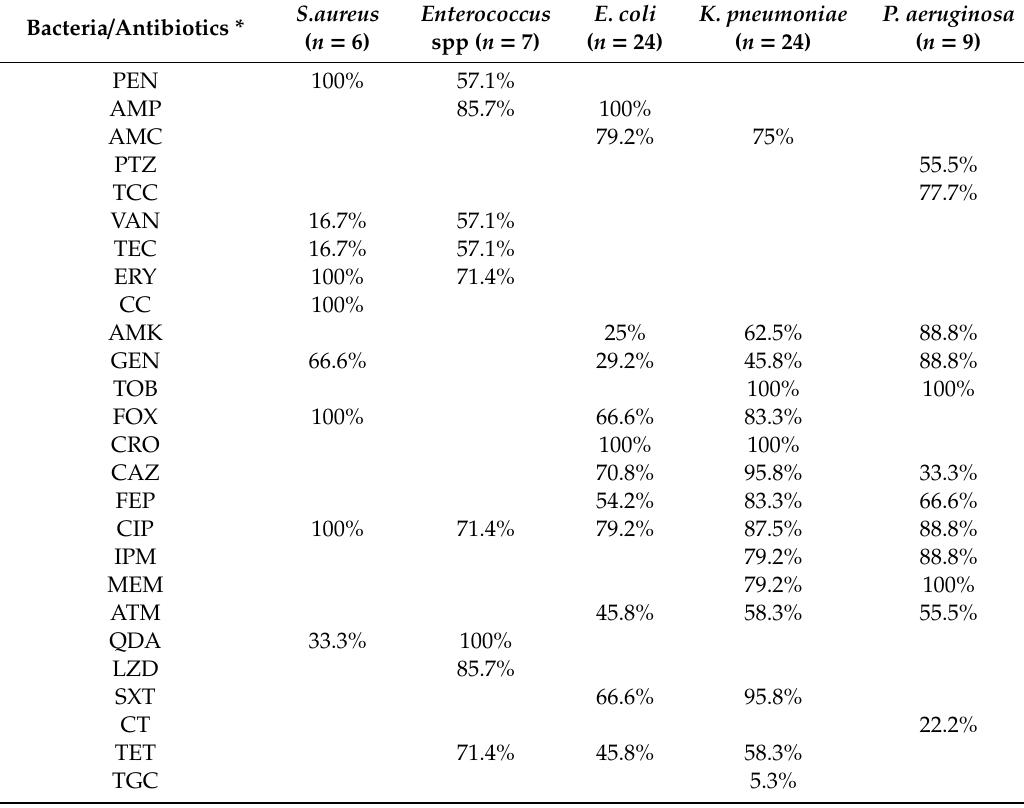
Table 1. Antibiotic resistance (%) profile of tested